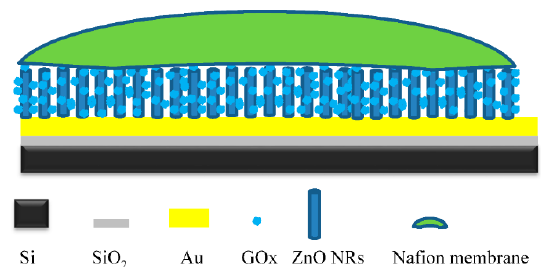
Figure 1. A schematic structure of the immobilized working electrode of the fabricated electrochemical glucose sensor.